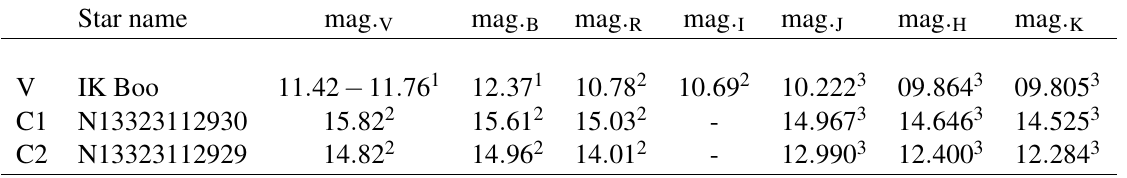
Table 2 The magnitude of IK Boo and the comparison stars in different filters